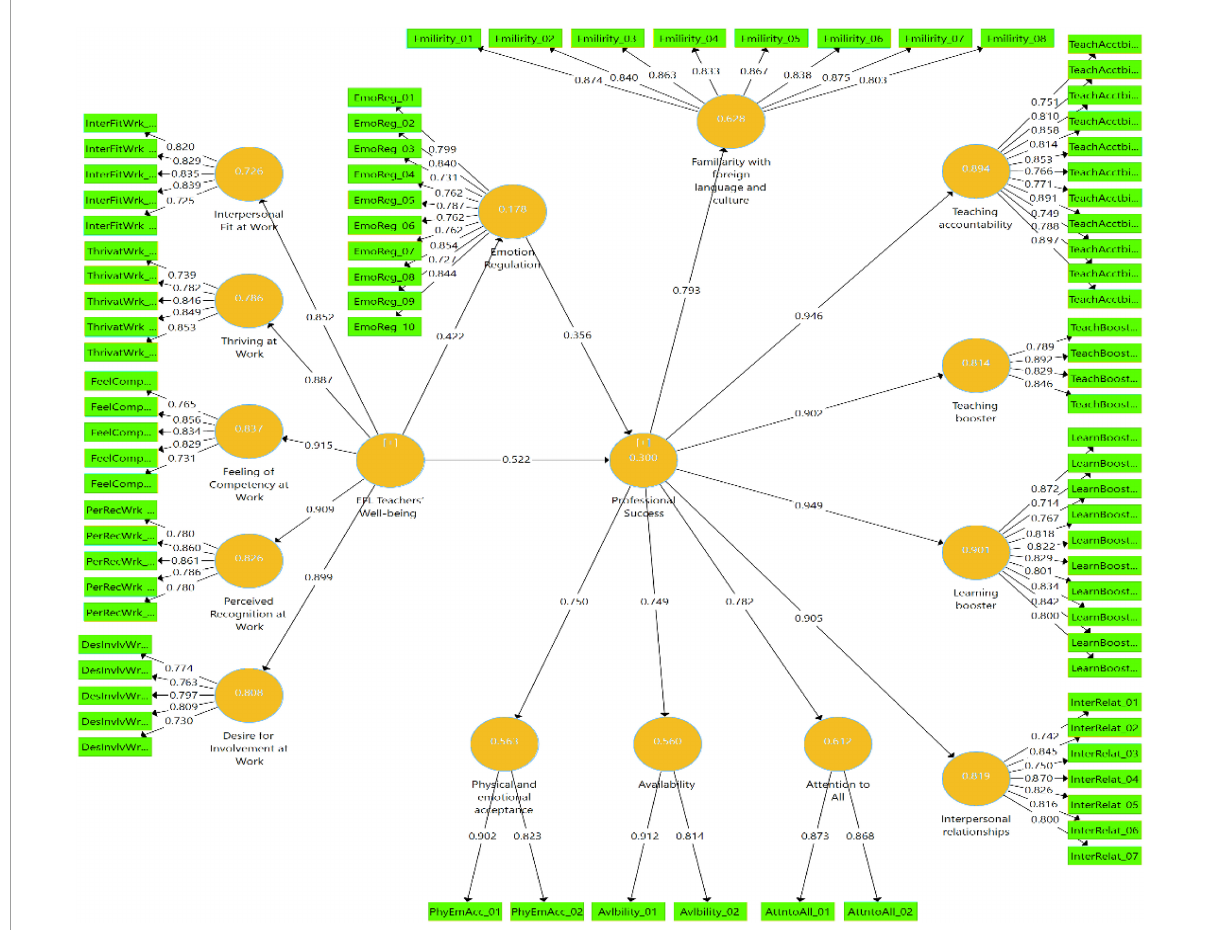
FIGURE1 The structural model of the relationships between well-being, emotion regulation, and teacher professional